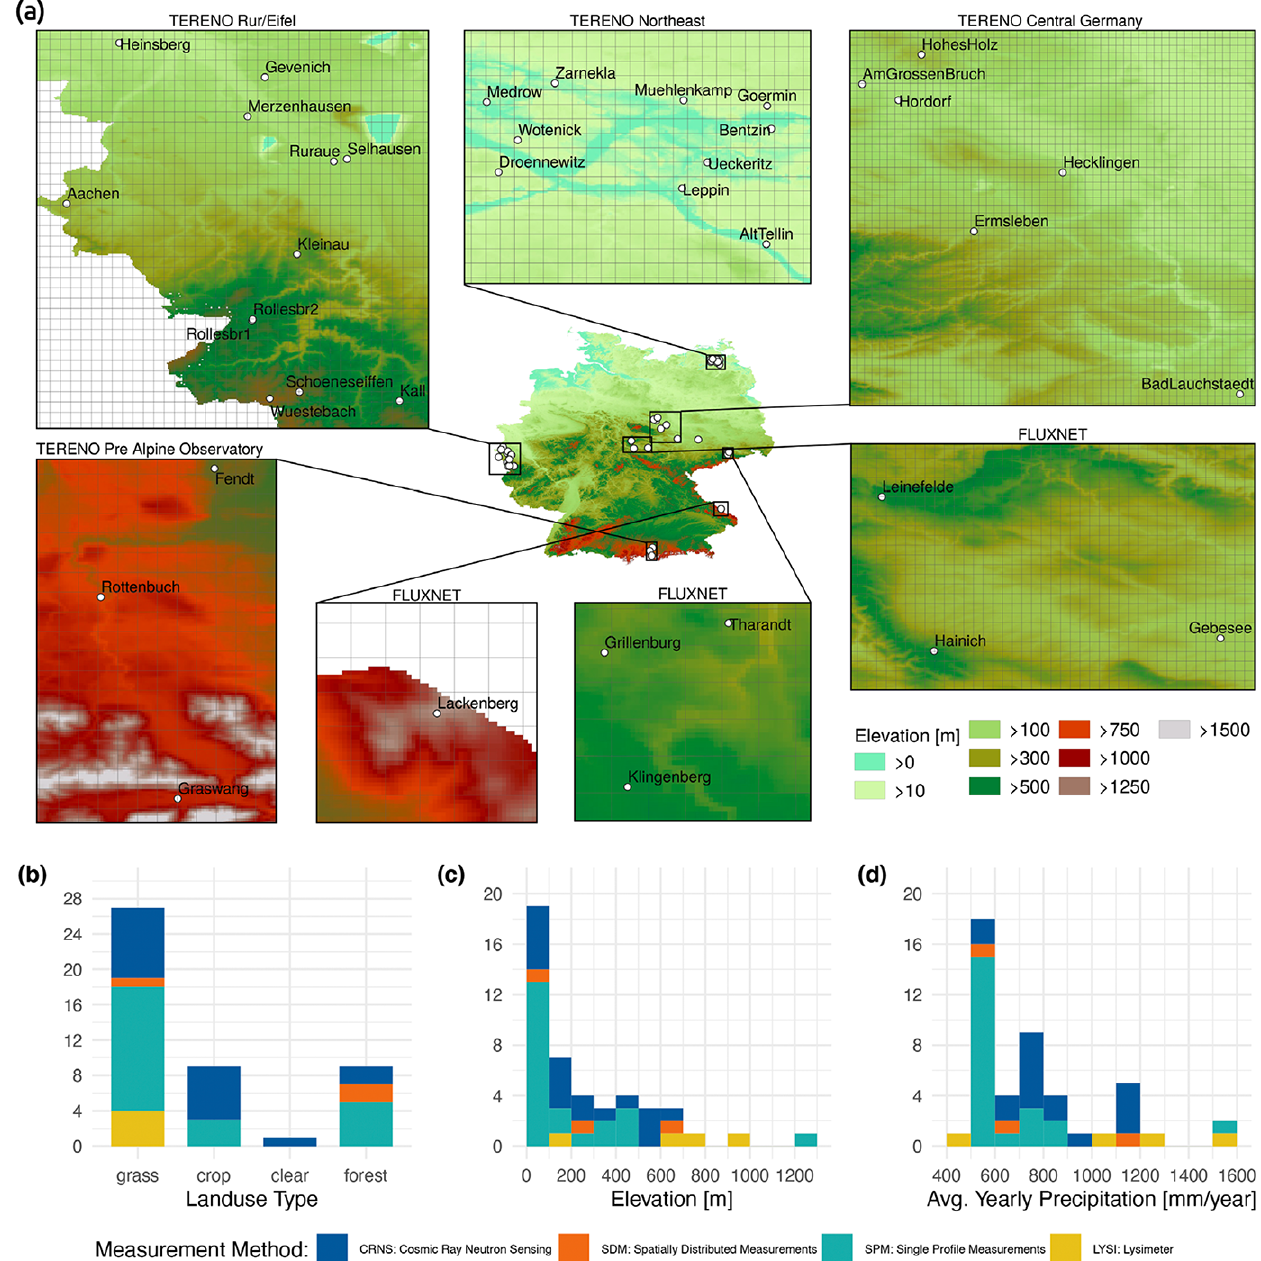
Figure 2. SM observations of 40 locations distributed over Germany were used in the SM evaluations of the GDM-v2-2021 and GDM- v1-2016 model setups. The subplots display the experimental sites in greater detail, representing different climate gradients in Germany. The maps show the digital elevation model on the hydrological subgrid variability resolution L0 of mHM in the GDM-v2-2021 setup (0.001953125 ◦ × 0.001953125 ◦ ). The grid corresponds to the modeling resolution L1 in the GDM-v2-2021 setup (0.01562 ◦ × 0.01562 ◦ , which equals ≈ 1.2km × 1.2km), at which the hydrological processes are simulated. The lower panel (b–d) shows the distribution of different SM observations depending on land use type, elevation, and average yearly precipitation. Note that some of the 40 locations have multiple SM data sources ( n =